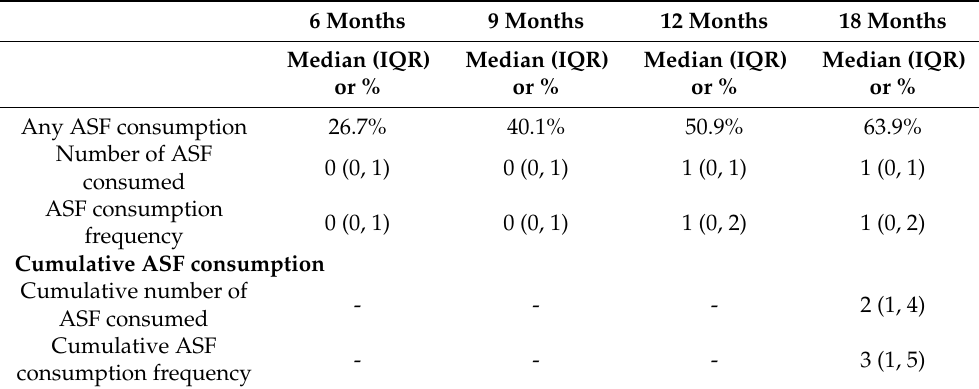
Table 2. Child’s ASF consumption by